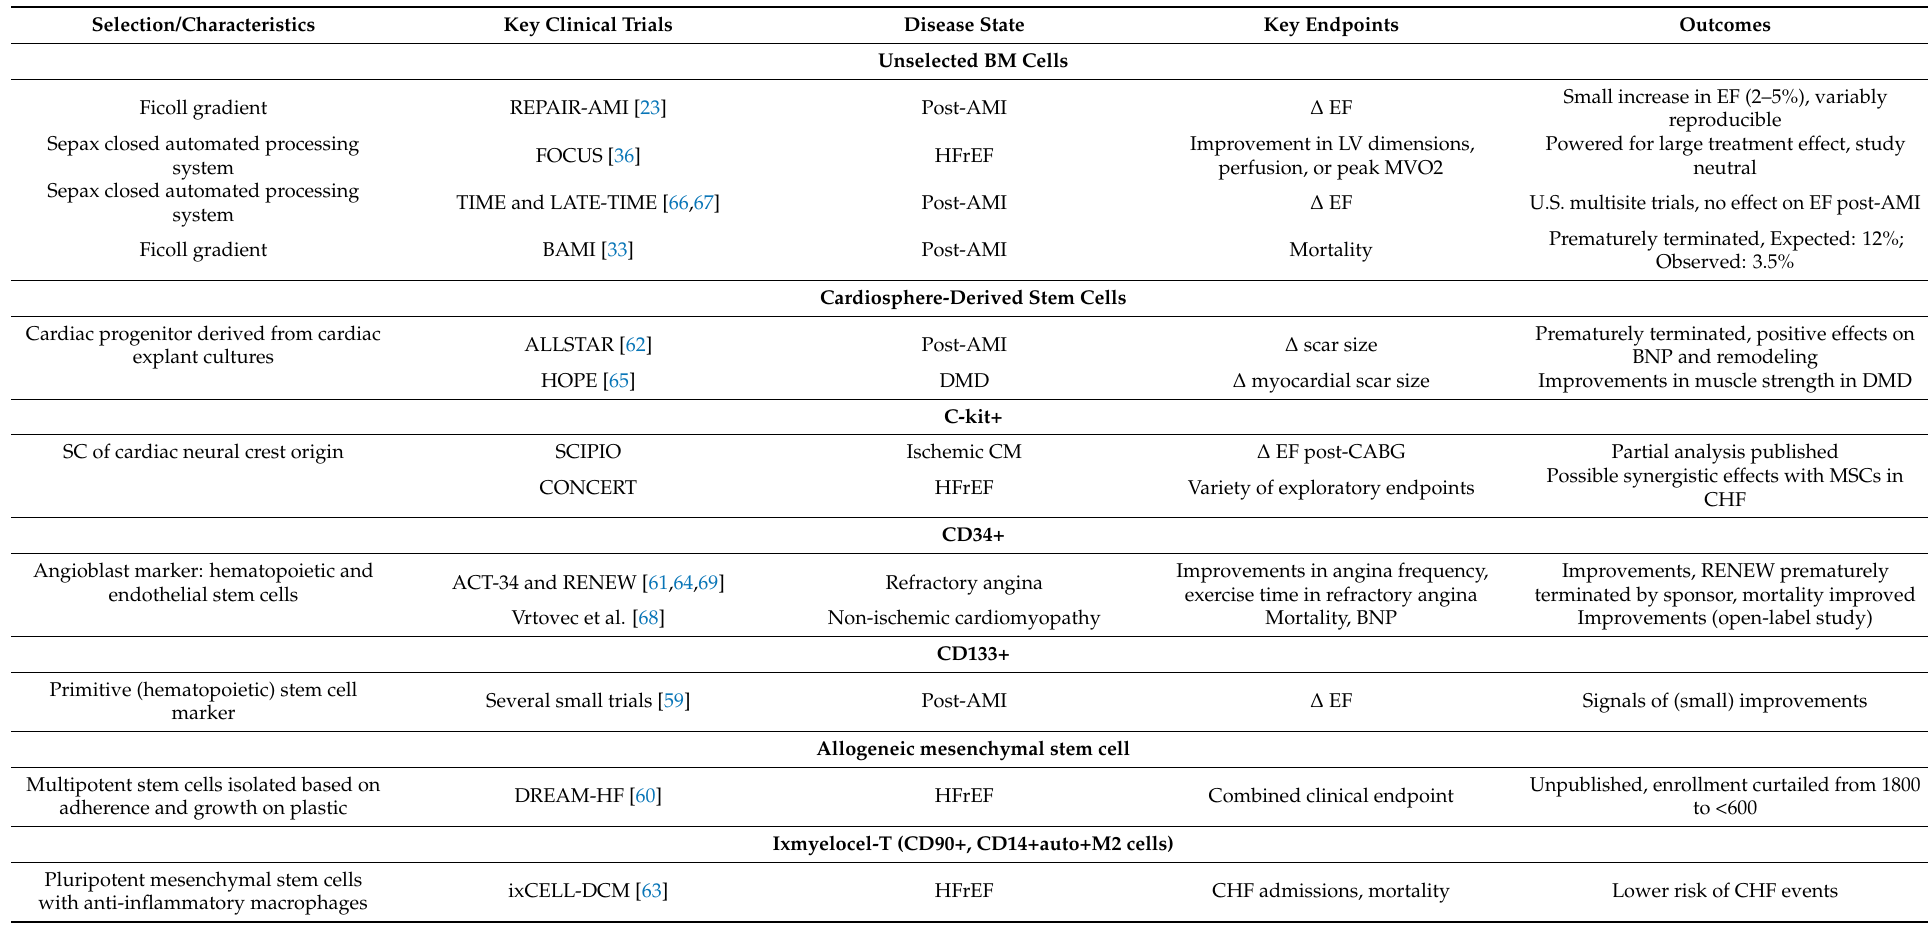
Table 1. Key Clinical Trials of Bone Marrow and Selected Cells for Cardiovascular